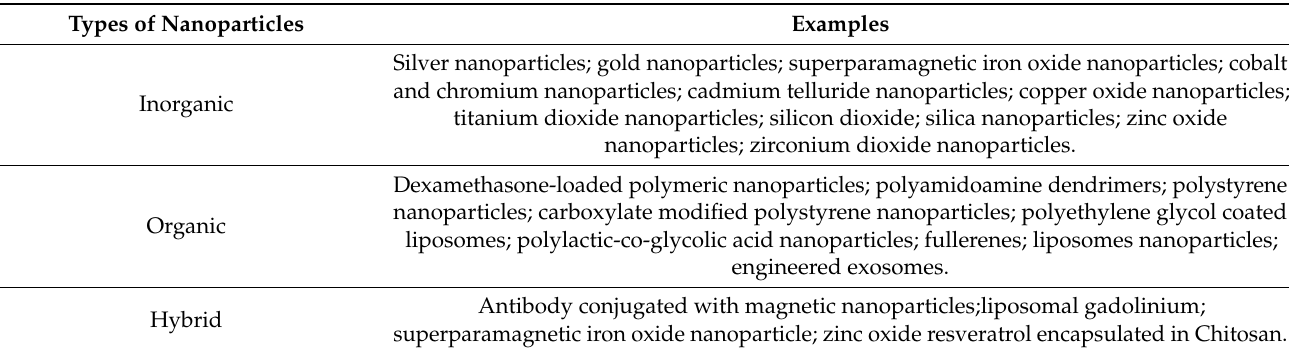
Table 2. Types of